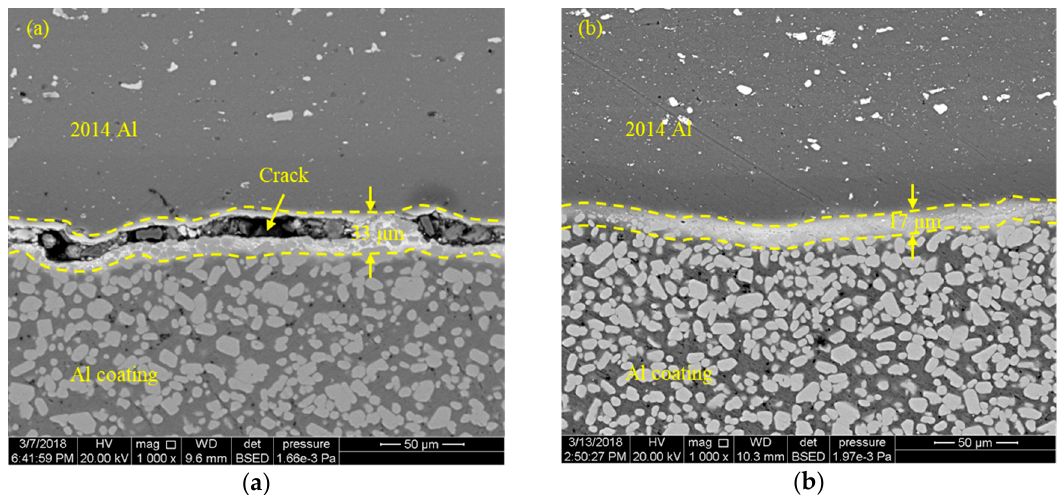
Figure 10. Microstructure of the brazing zone of the FSSW-B joint made at the tool rotation speed of ( a ) 900 rpm and ( b ) 1500 rpm.